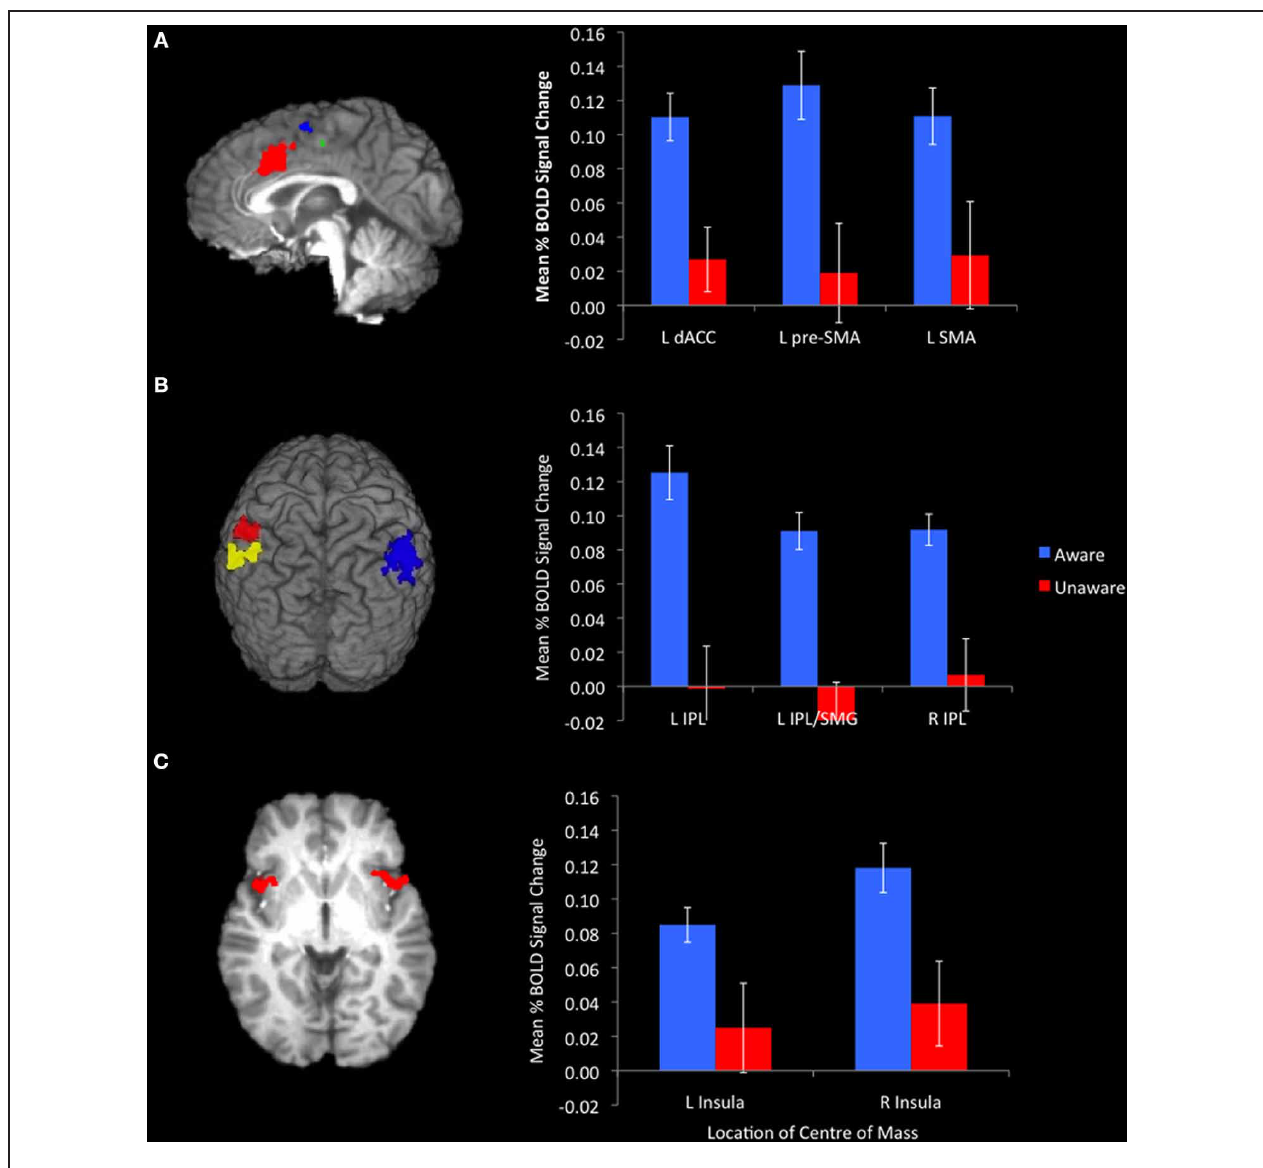
on the L-IPL, yellow cluster centered on the L-IPL/SMG, blue cluster centered on the R-IPL], and insulae [ (C) axial slice at z = 0]. Bar graphs represent mean %BOLD signal change relative to baseline for aware and unaware